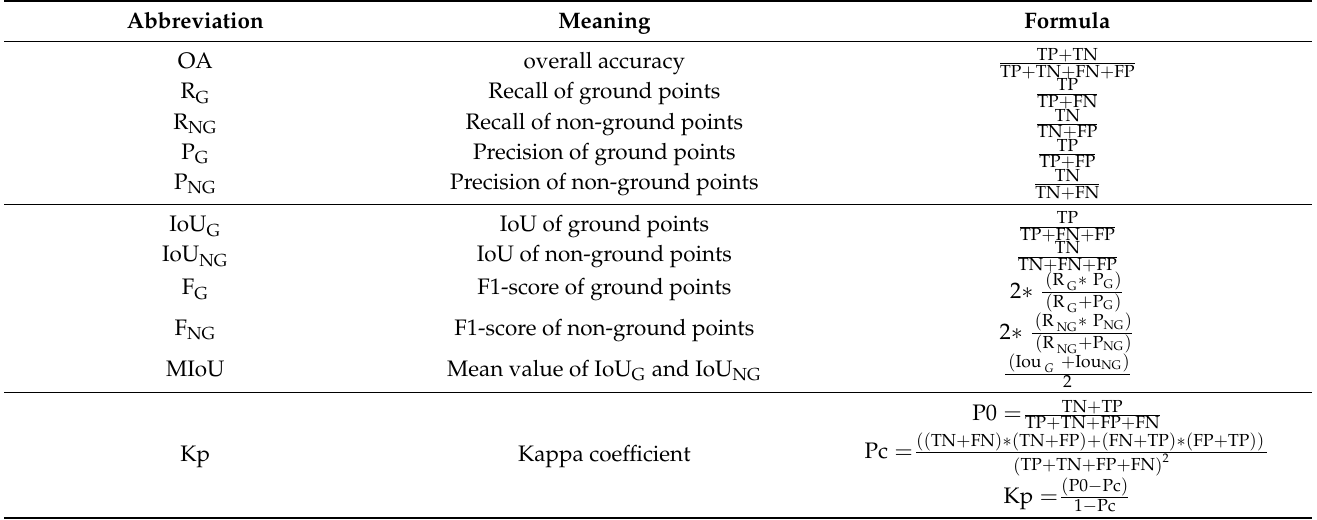
Table A3. Summary of calculation formulas for performance